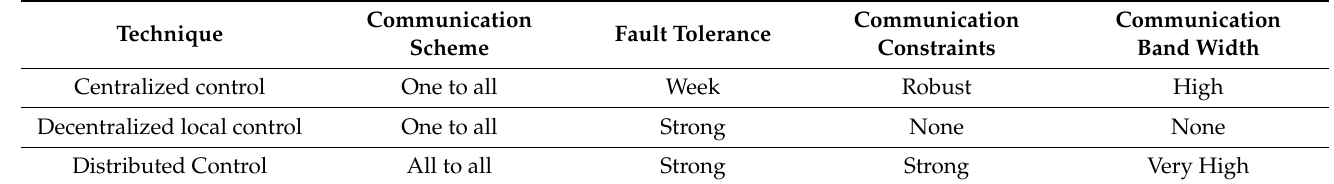
Table 1. The main aspects of each control technique.